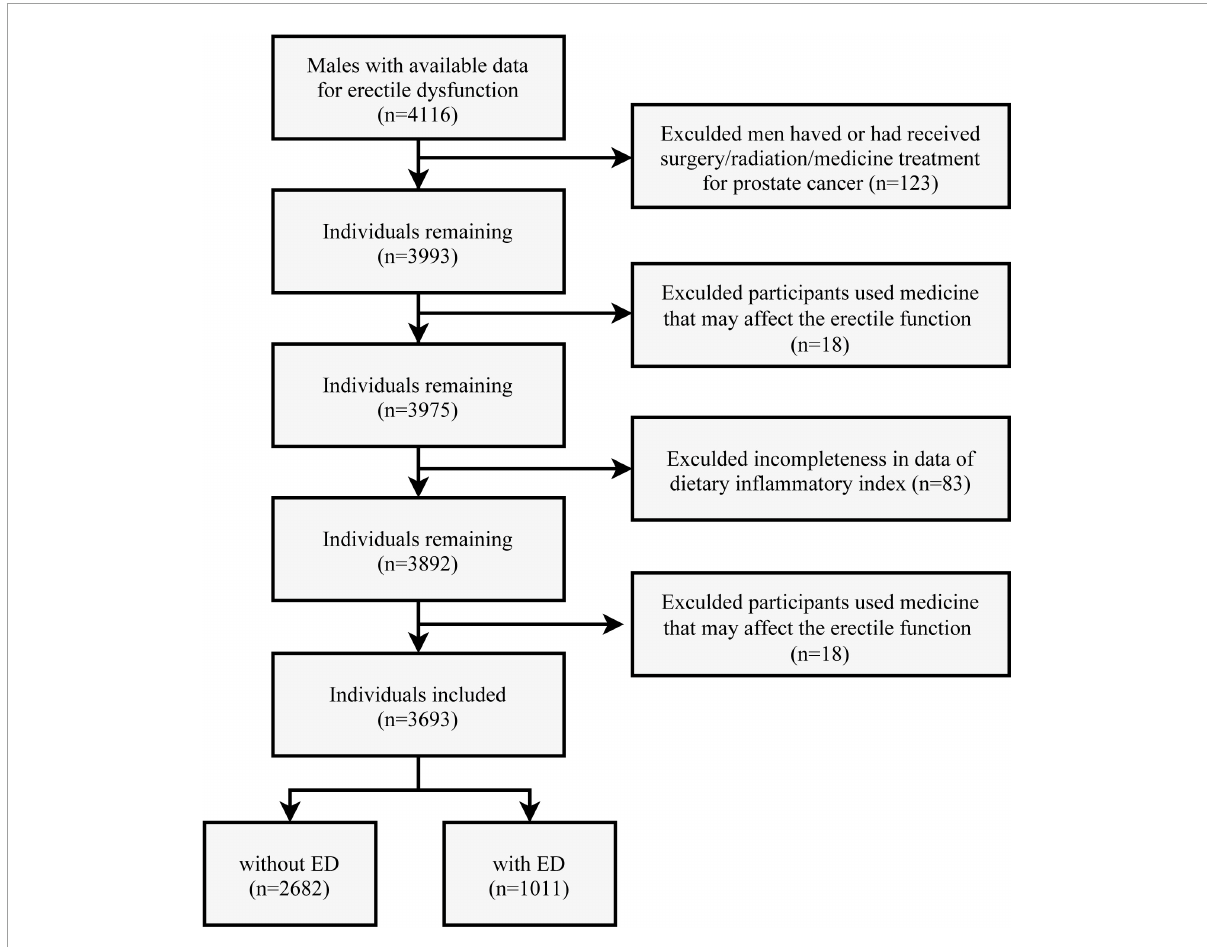
FIGURE1 Flow diagram of the screening and enrollment of study participants.